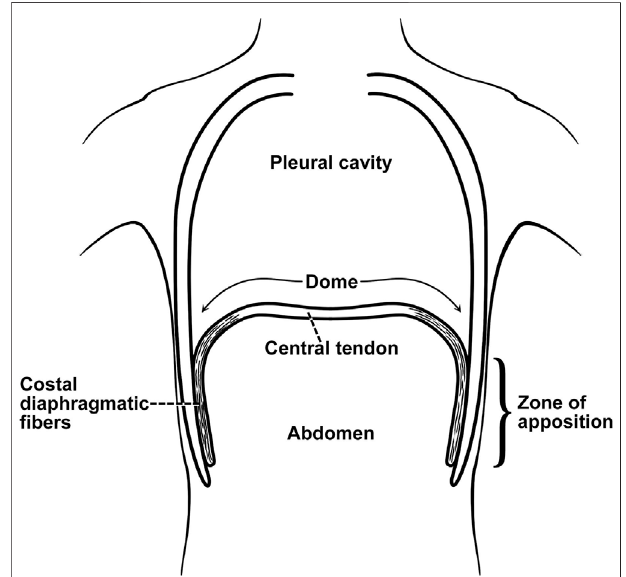
FIGURE 2 | Zone of apposition of the diaphragm. The muscle fi bers of the diaphragm originate from the circumference of the thoracic outlet, in particular the lower ribs, and converge to insert into a central tendon). From their origins on the lower ribs the fi bers run mainly cranially and are directlyparallel(apposed)totheinneraspectofthelowerribcage,constituting the “ zone of apposition. ” From (Troyer and Wilson, 2016).